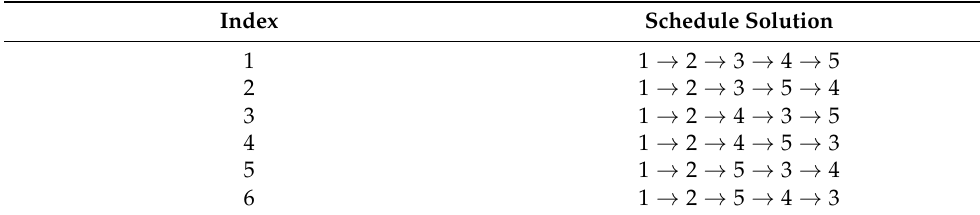
Table 4. VSP optimization sequence analysis.